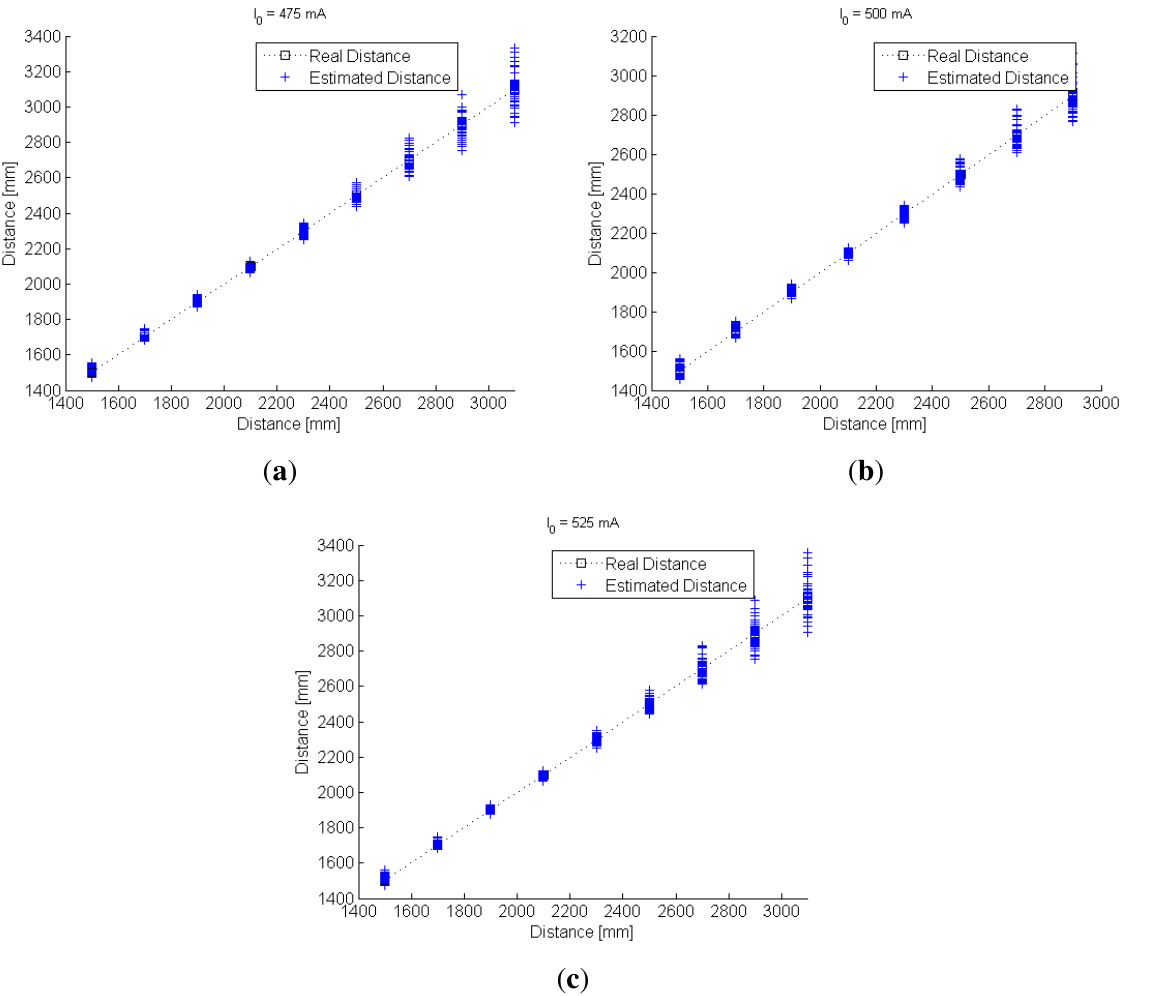
Results of the distance estimation process considering all available (cid:52) t and all IRED orientation angles. ( a ) for a bias current of 475 mA, ( b ) for 500 mA and ( c ) for 525